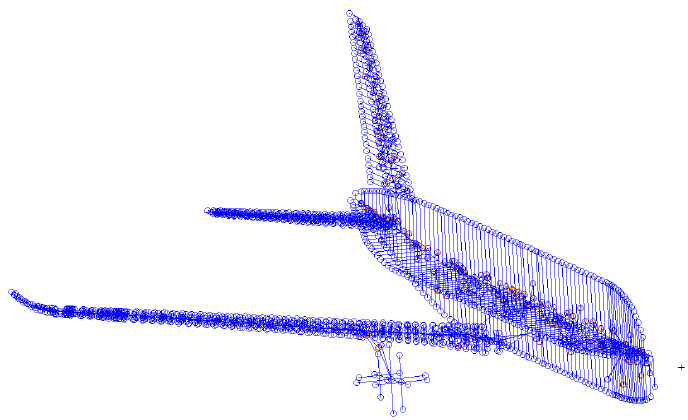
Figure 5. Structural model for the CFD/CSD coupling method. Two ‐ degree freedom, including the α degree and ϕ degree, was considered in this advanced ECFT correction, and the α degree is the main mode. The CFD results with the two ‐ degree freedom were also simulated as a correction source to correct the linear sub ‐ sonic wing–body interference DLM